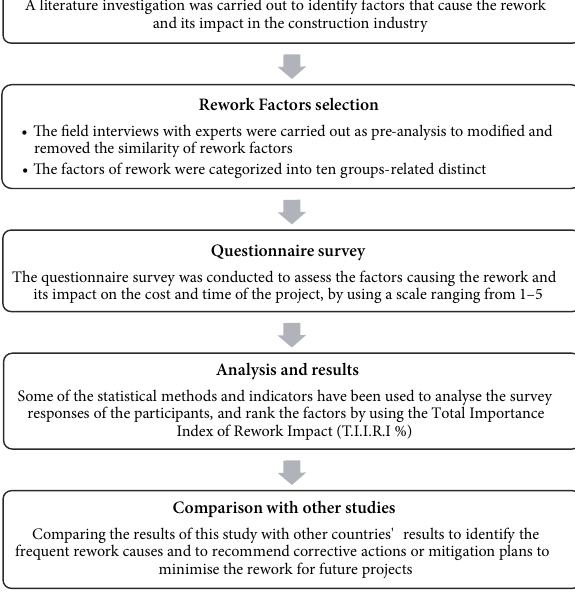
Figure 1. The research